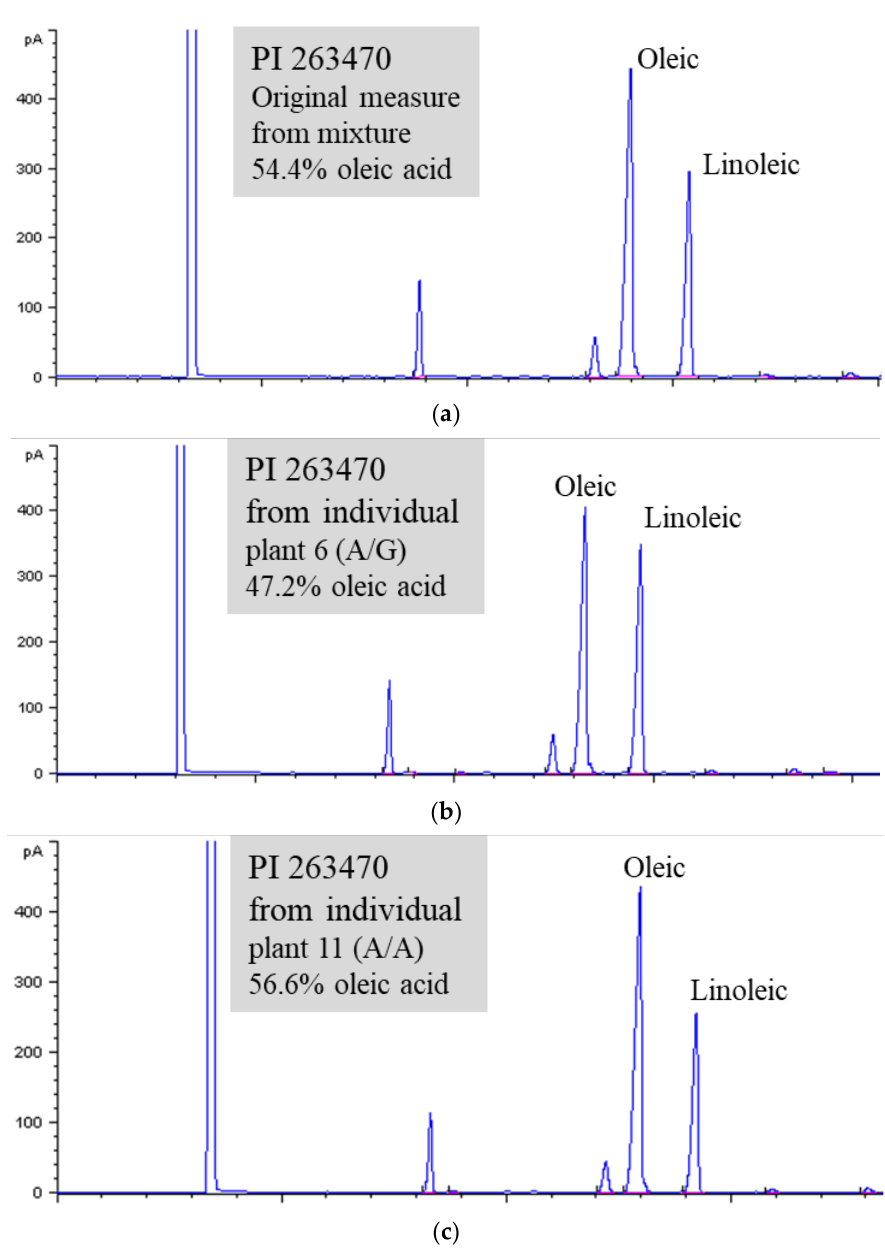
Figure 1. The levels of oleic acid and linoleic acid shown on chromatograms from three genotypes. ( A ). Mixed genotypes (A/A and A/G). ( B ). Genotype A/G. ( C ). Genotype